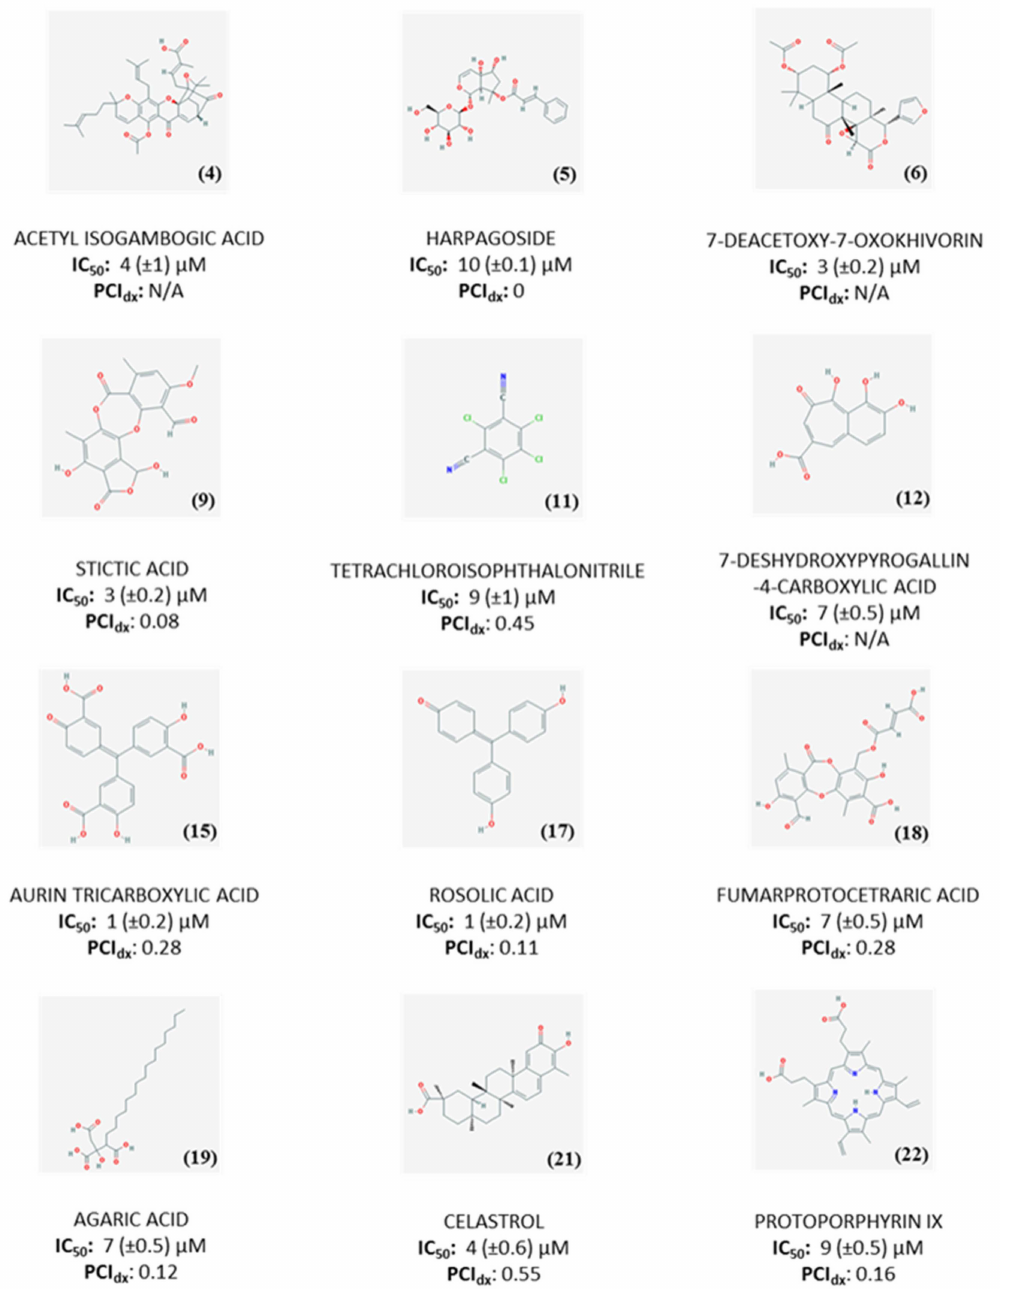
Figure 4. Structures, IC 50 values and PCIdx for 12 compounds with IC 50 ≤ 10 µ M against